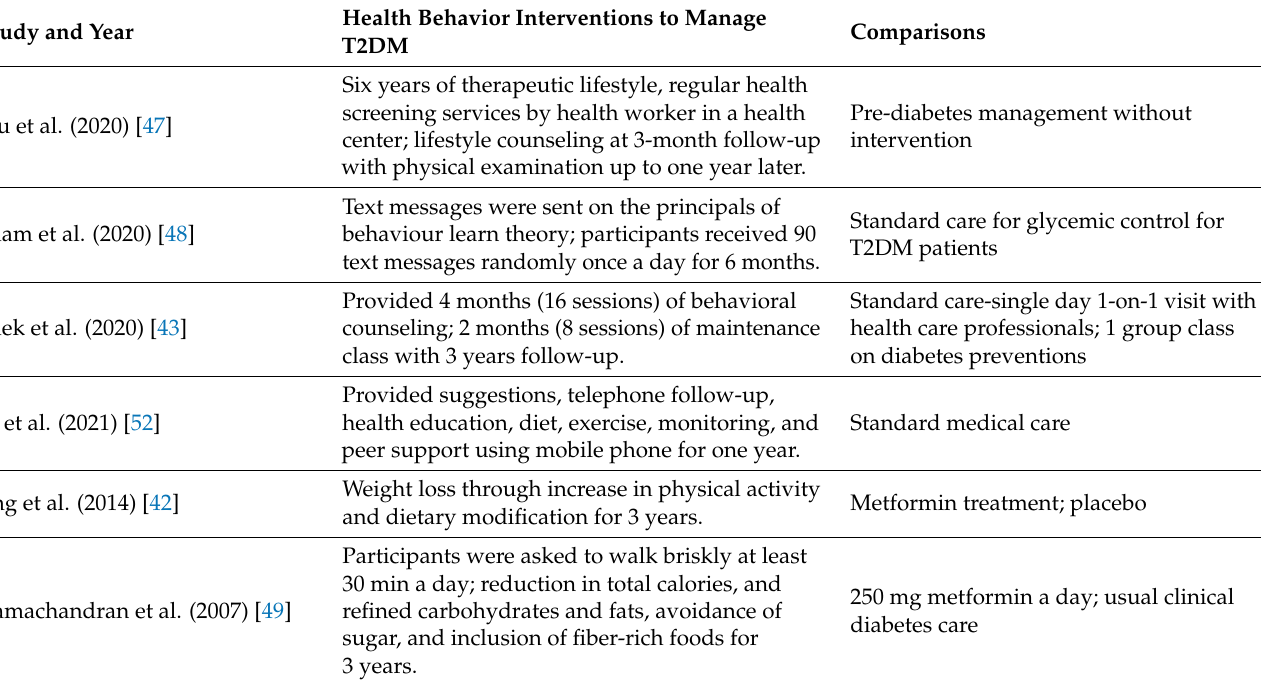
Table 3. Details of health behavior interventions to manage T2DM and